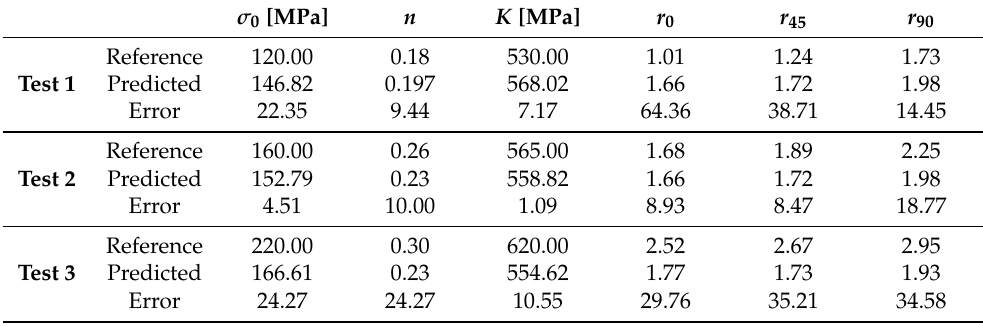
Table 6. Predictions with the ANN inverse cruciform model using the noise-polluted dataset. σ 0